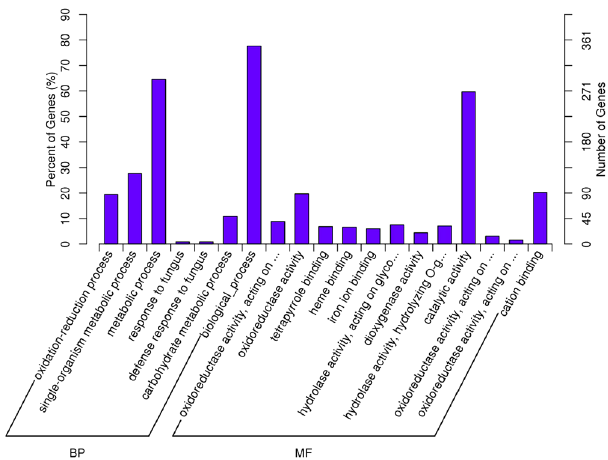
Figure 6. Gene Ontology analysis of differentially expressed genes in ABA vs. CK.